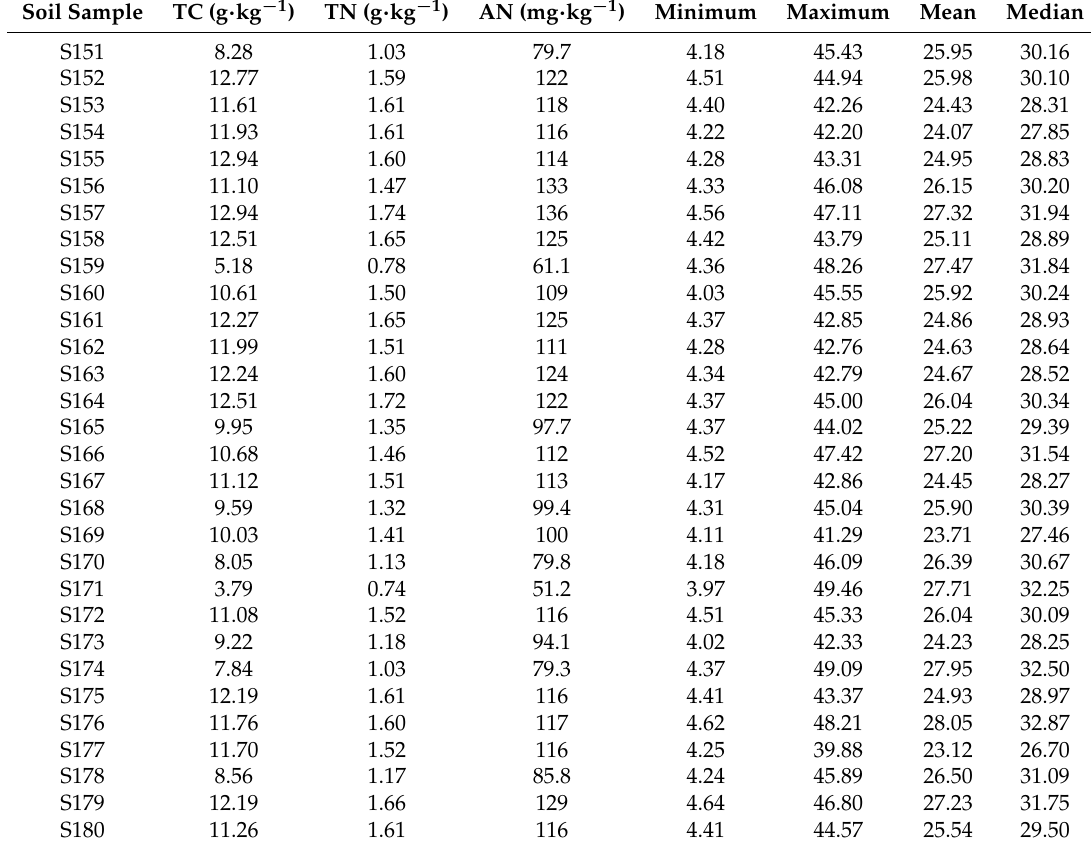
Table A4. Basic information on samples from S151 to